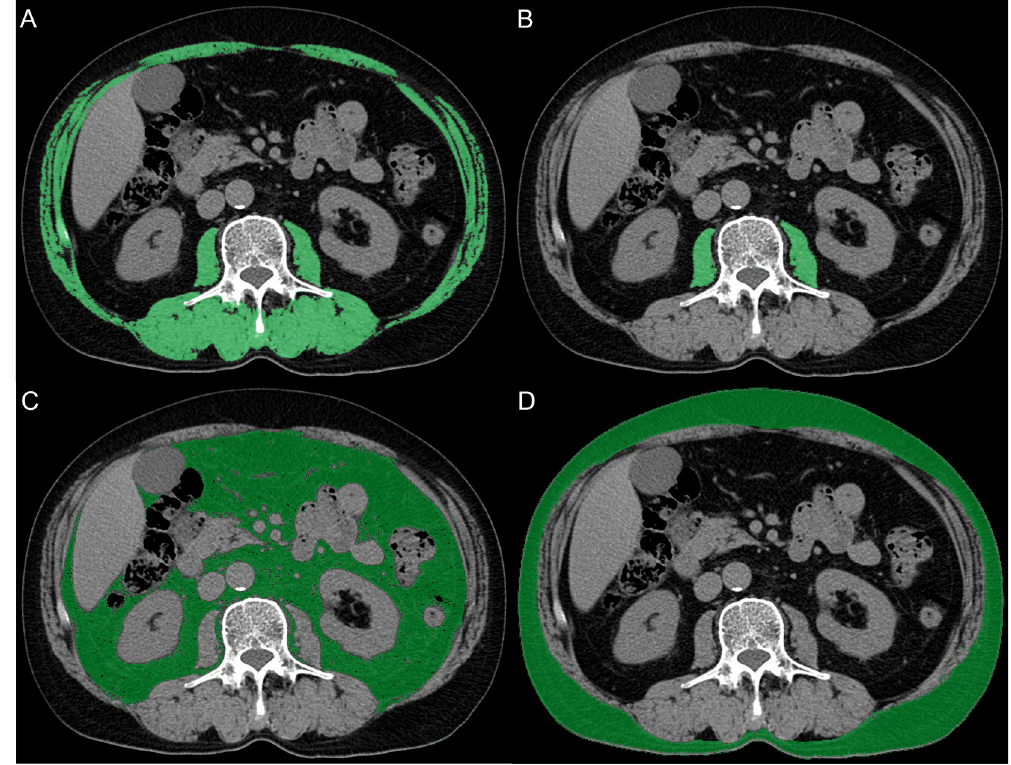
Figure 1. Computed tomography images of the third lumbar vertebra for each area. (a) Green highlights indicate the skeletal muscle area for the skeletal muscle index. (b) Green highlights indicate the psoas muscle area for the psoas muscle index. (c) Green highlights indicate the visceral adipose tissue area for the visceral adipose index. (d) Green highlights indicate the subcutaneous adipose tissue area for the subcutaneous adipose